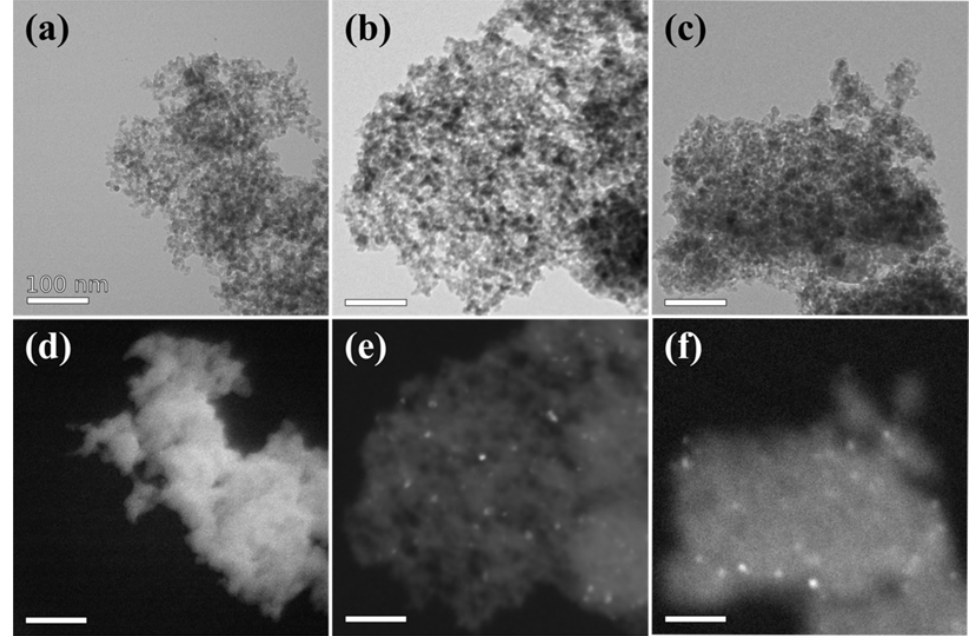
Figure 3. Representative BF ( a – c ) and DF ( d – f ) transmission electron microscopy (TEM) images of aerogel samples treated at 900 °C with increasing loading of 5 wt% ( a , d ), 10 wt% ( b , e ) and 15 wt% ( c , f ). All scalebars correspond to 100 nm.